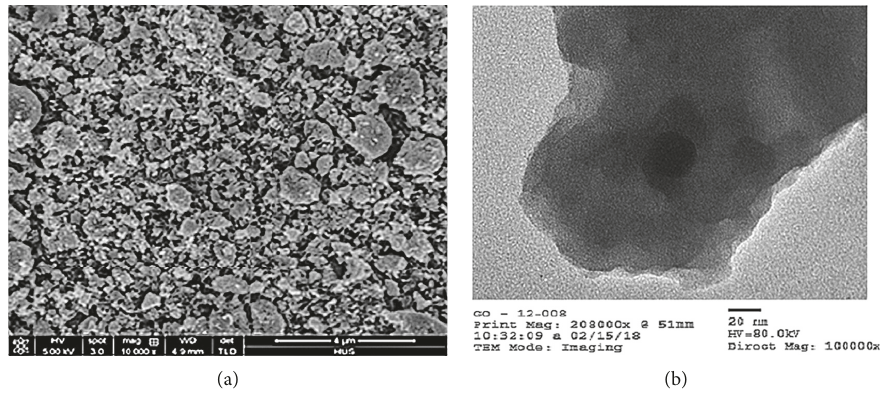
Figure 2: SEM and TEM images of GO.